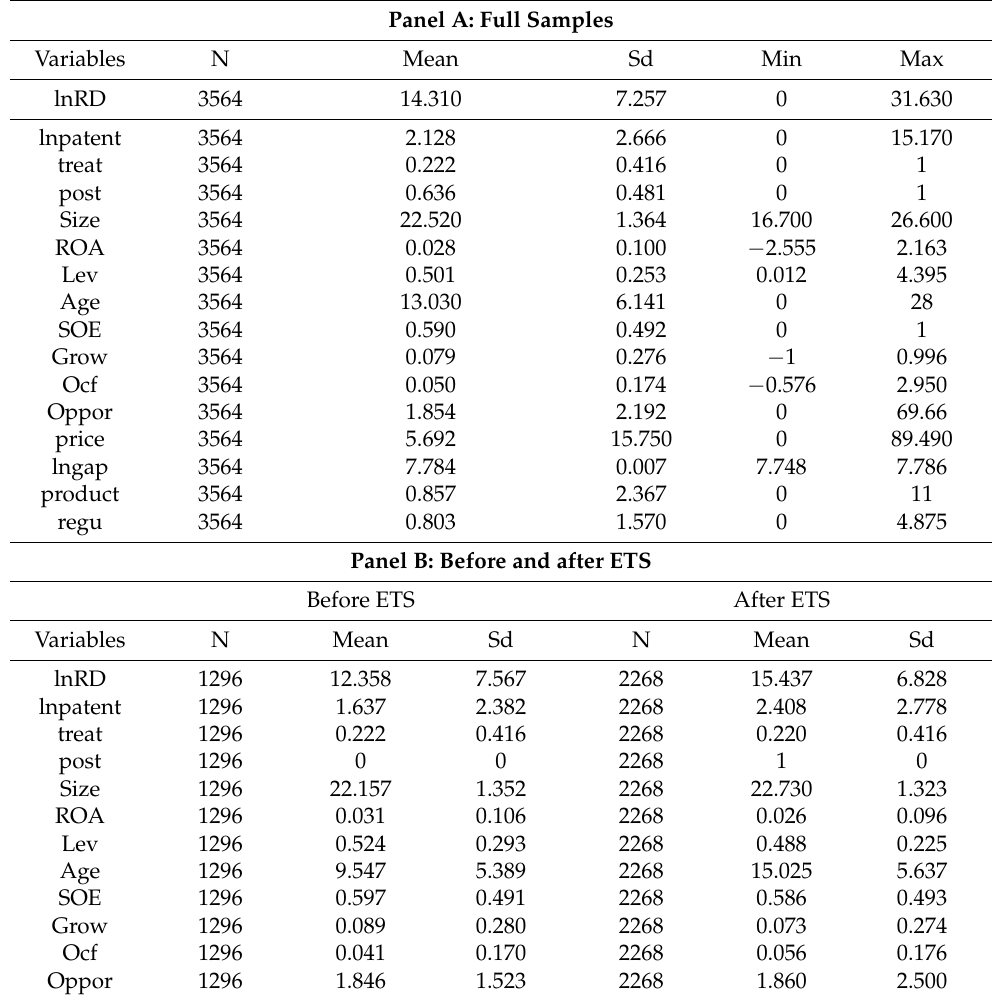
Table 2. Descriptive